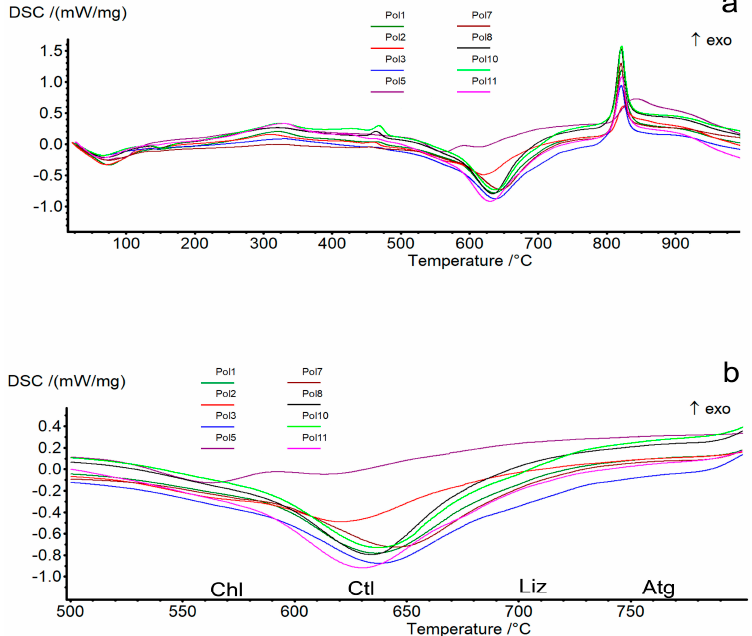
Figure 6. ( a ) Comparison among differential scanning calorimetry (DSC) curves of the soils located within or near the village of San Severino Lucano Village (Basilicata, Southern Italy); ( b ) zoom of ( a ) in the temperature range of 500–800 °C. DTG curves appear to be similar for most of the samples and show the main endothermic peaks related to the mineralogical phases decomposition between 500 and 830 °C (Figure 7). A weak endothermic peak at 563 and 564 °C for Spol2 and Spol5 respectively, is linked to the presence of a small amount of chlorite. For all samples, the very strong endothermic peak in a temperature range of 614–639 °C, clearly showed the presence of chrysotile in high amount (Table 2). Polygonal serpentine occurs in most of the samples showing a weak endothermic peak in a range of 677–688 °C, whereas only two samples, Spol3 and Spol5, are characterized by an endothermic shoulder at 736 and 744 °C related to the presence of lizardite (Table 2). Finally, the occurrence of antigorite is confirmed by the endothermic peak in a T range of 770–790 °C (Table 2). Figure 7. Comparison among DTG curves in the temperature range of 500–850 °C: endothermic peaks related to chlorite (Chl), chrysotile (Ctl), polygonal serpentine (PS), lizardite (Liz) and antigorite (Atg) decomposition. The TG data reported on Table 3, show the values of 1–4% mass loss at a temperature up to 110 °C due to the adsorbed water and total weight losses of about 12–18% up to 1000 °C in all of the samples,